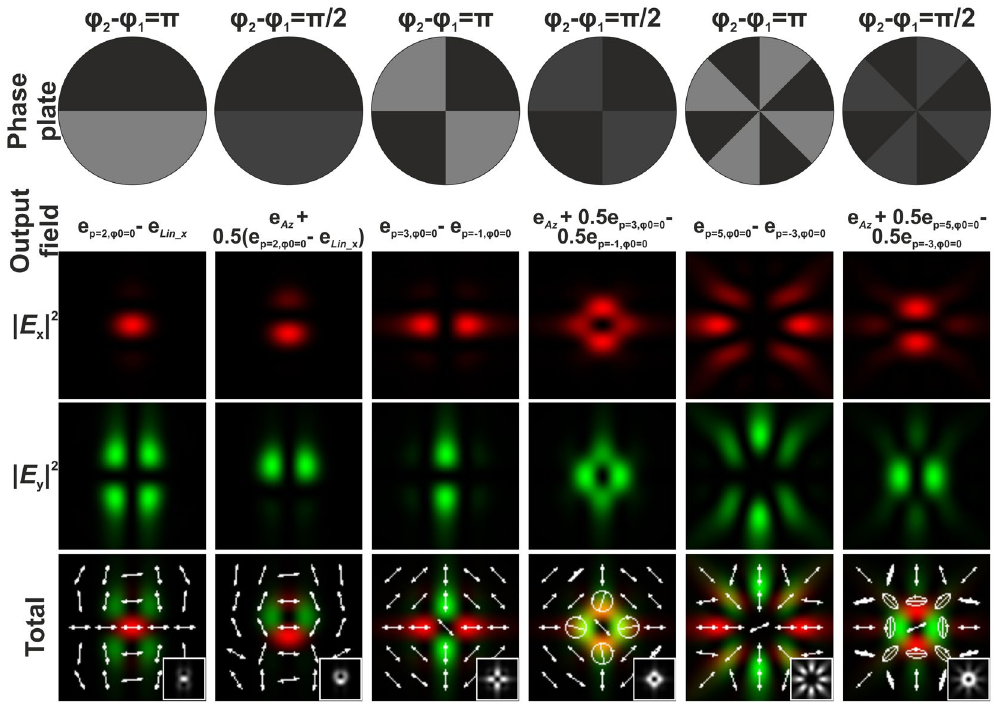
Figure 5. Transformation of the initial azimuthally polarised laser beam passed through different binary multi- sector phase plates. In fact, the generated output fields are superpositions of different CVBs. The distribution of the various components of the electric field in the focal plane of a focusing system (NA = 0.99) are shown. The insets in the total field distribution images show the generated grayscale intensity distributions. The white arrows show the schematic polarisation